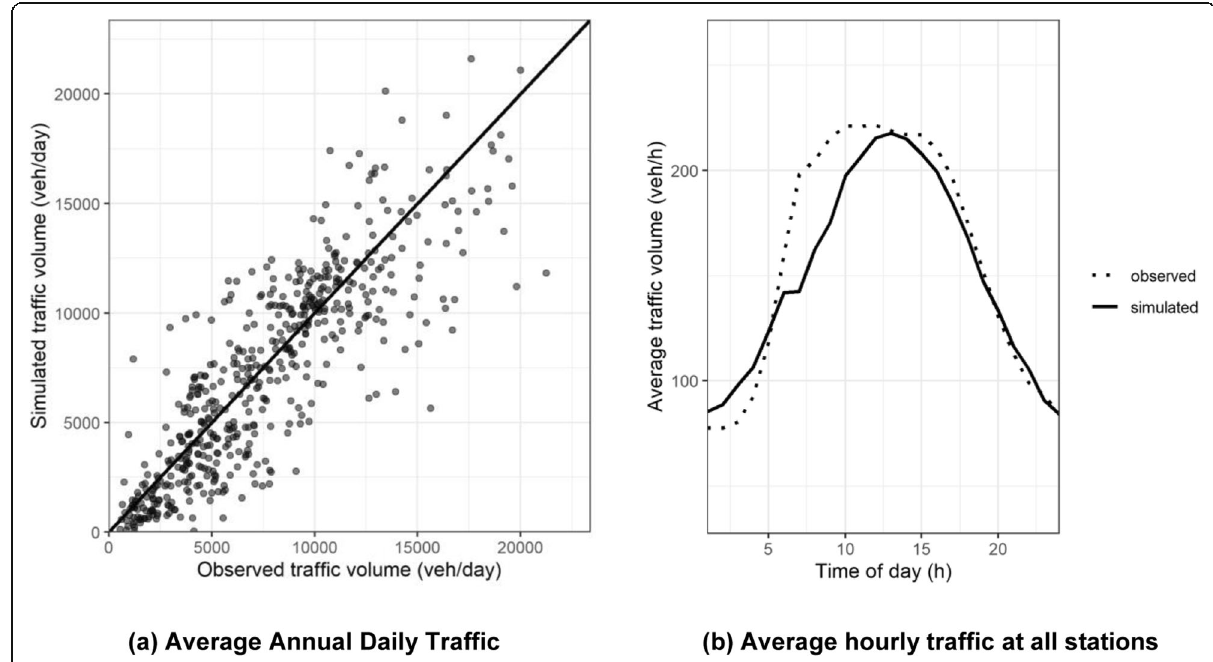
Fig. 4 Comparison of simulated and observed truck counts